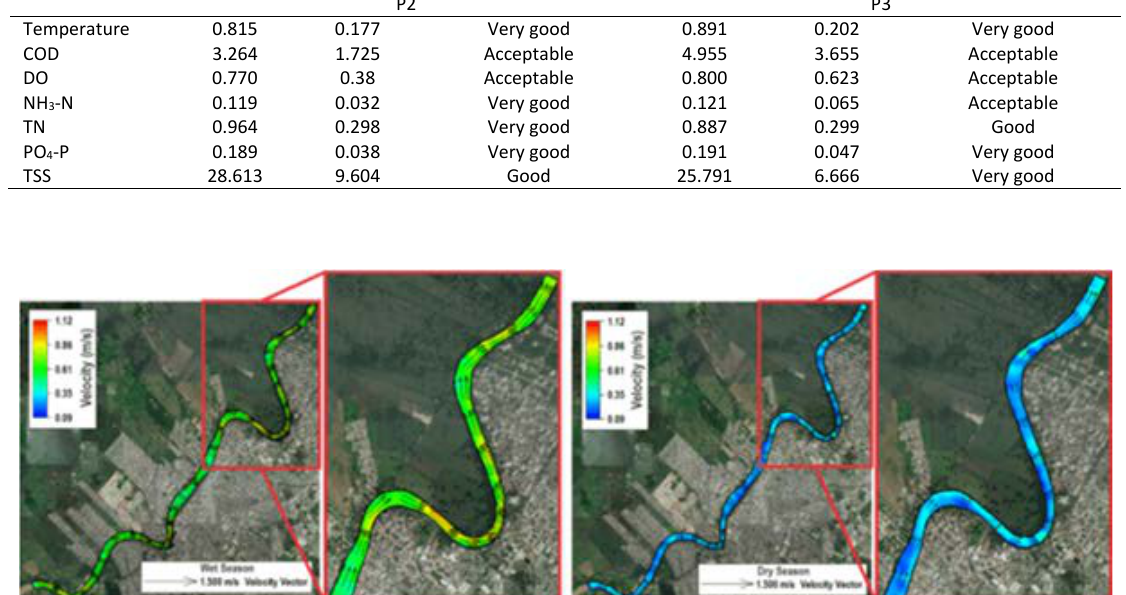
Fig.6: Dry and wet season velocity simulation